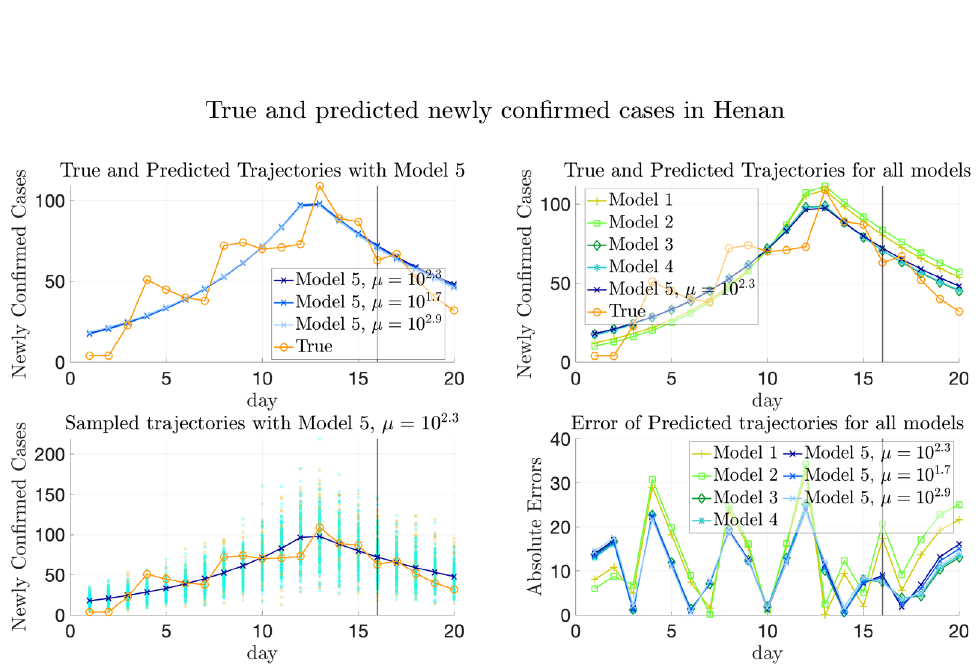
Figure 9. True and fitted trajectories in Henan. The remarks for the lines and scatter plots are the same as those in Figure 8. For Model 5, µ = 10 1.7 , 10 2.3 , and 10 2.9 are chosen. As shown in Fig. 12 and Supplementary Fig. S5, the validation errors are minimized at µ ∗ = 10 2.3 . µ = 10 1.7 and 10 2.9 are obtained by perturbing the minimizer µ = 10 2.3 without increasing validation errors much. µ = 10 1.7 , 10 2.3 , and 10 2.9 are marked by yellow pentagrams, blue squares, and green diamonds respectively in Fig. 12 and Supplementary Fig.